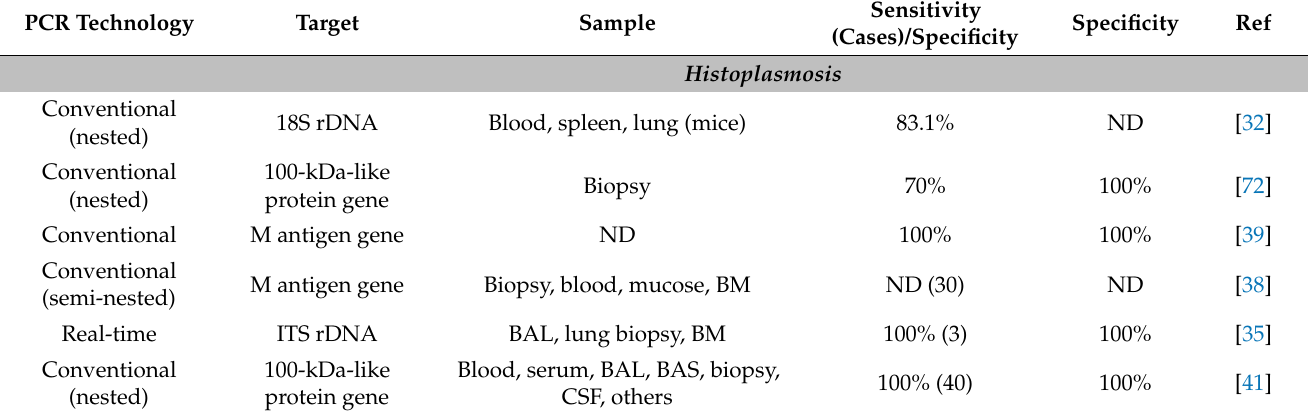
Table 1. Details of the studies where specific PCR assays were used to diagnose endemic